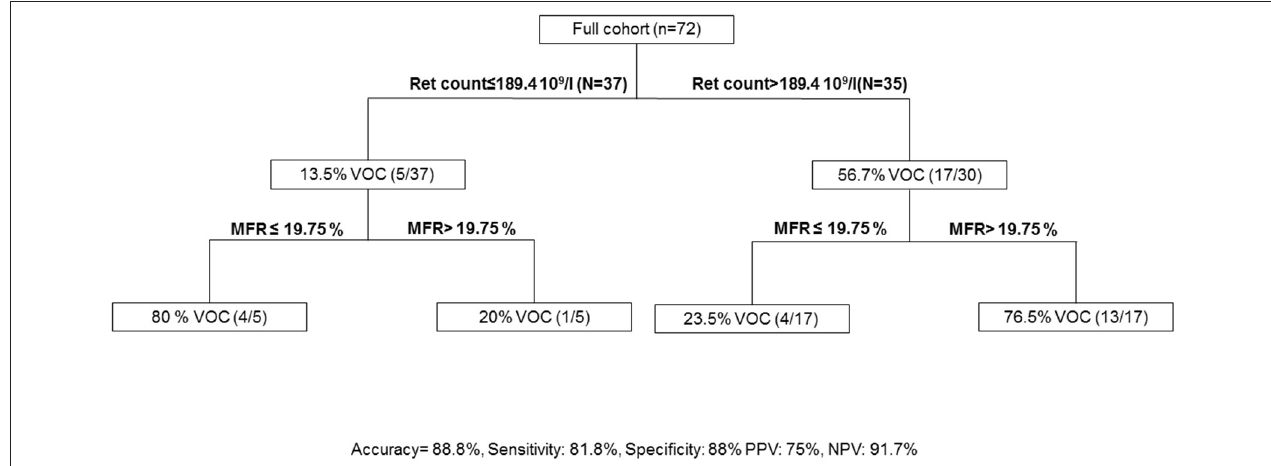
FIGURE 3 | Algorithm to predict vaso-occlusive crisis. MFR, medium fluorescent reticulocytes; Ret count; reticulocyte count; PPV, Positive Predictive Value; NPV, Negative Predictive Value; VOC, Vaso-occlusive